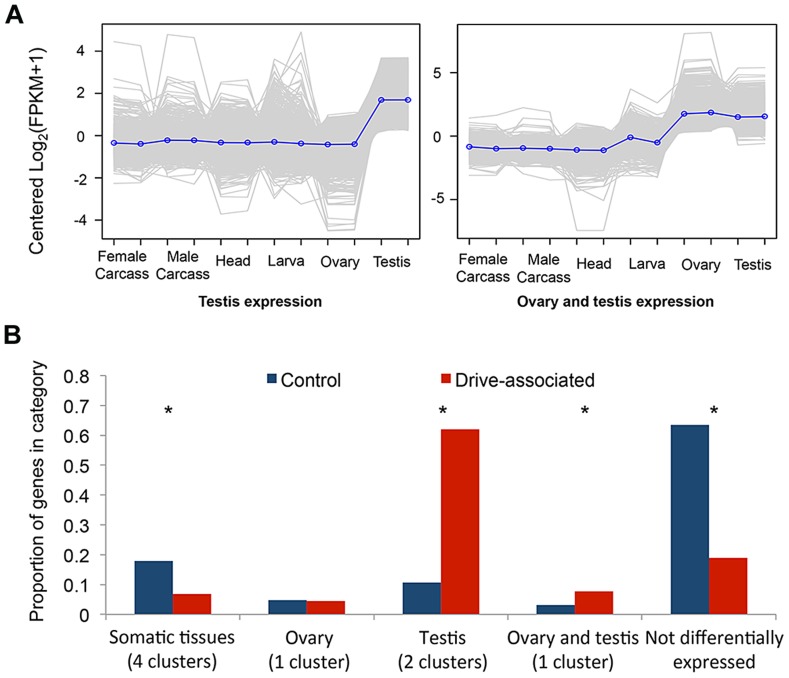
Drive-associated transcripts are enriched in the gonads.(A) K-means clustering was used to establish qualitatively distinct expression patterns of transcripts across the six sequenced tissues; clusters enriched for transcripts expressed predominantly in testes or in ovary plus testes are shown. Each grey line represents expression of a single transcript, and the blue line is the mean across all transcripts in the cluster. (B) Compared to control transcripts, drive-associated transcripts were more likely to have a significant expression pattern (categories other than “Not differentially expressed”), and in particular were enriched for two clusters associated with expression in the testis. Drive-associated transcripts were also enriched in a small cluster of transcripts expressed in both the ovary and the testes but not ovary alone. Control transcripts were more likely than drive-associated transcripts to be present in one of the somatic expression clusters (head, larvae, and adult carcass and larvae).